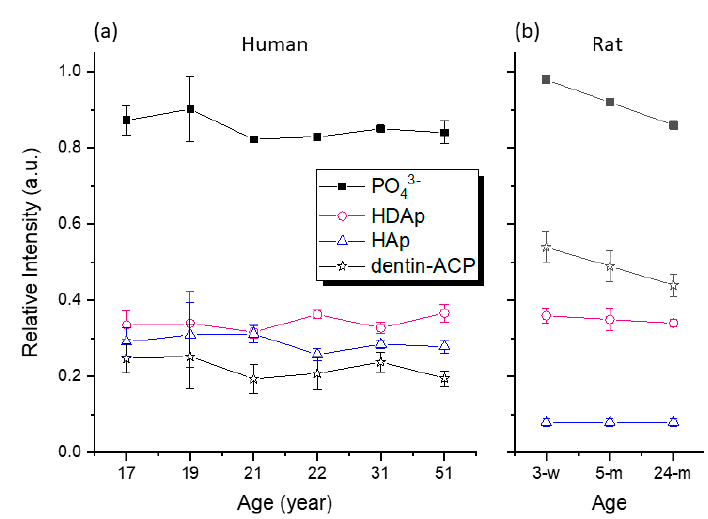
Figure 5. Distribution of the amounts of different phosphorus species normalized on the basis of the sample mineral content. ( a ) Results obtained for human dentin; ( b ) results for rat dentin taken from the literature [8].